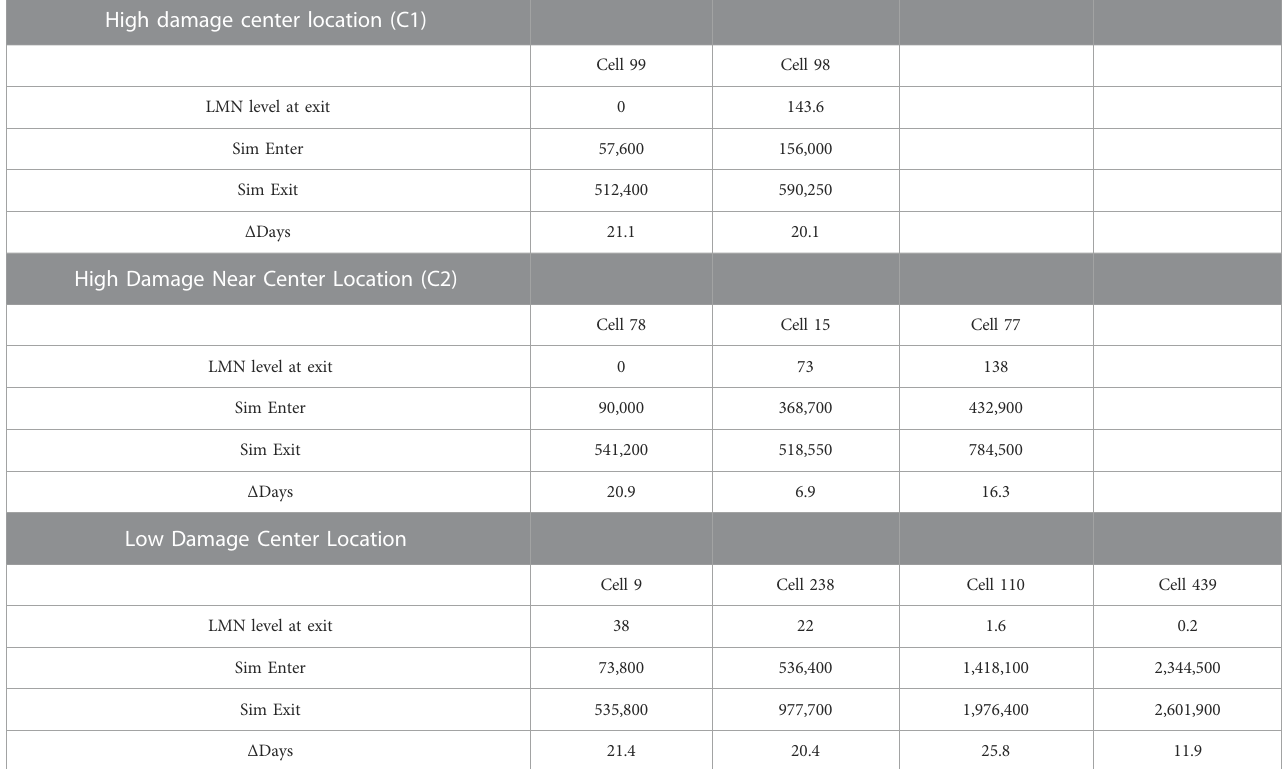
TABLE 2 Macrophages from non-smoking heavy and low damage COPD cells located at the center of the grid. Cells listed in order of appearance in simulation. High damage center location (C1)